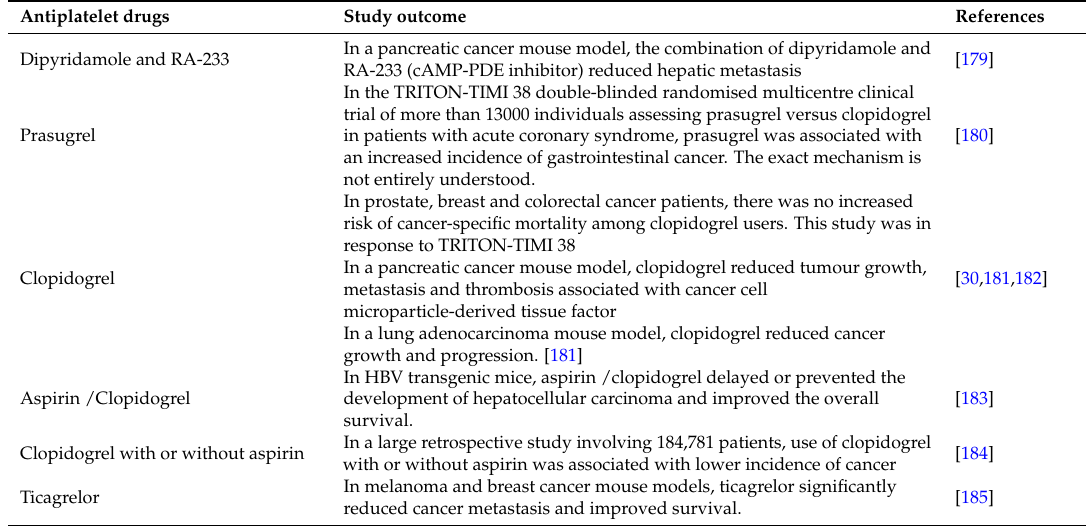
Table 4. Examples of antiplatelet drugs investigated in the context of